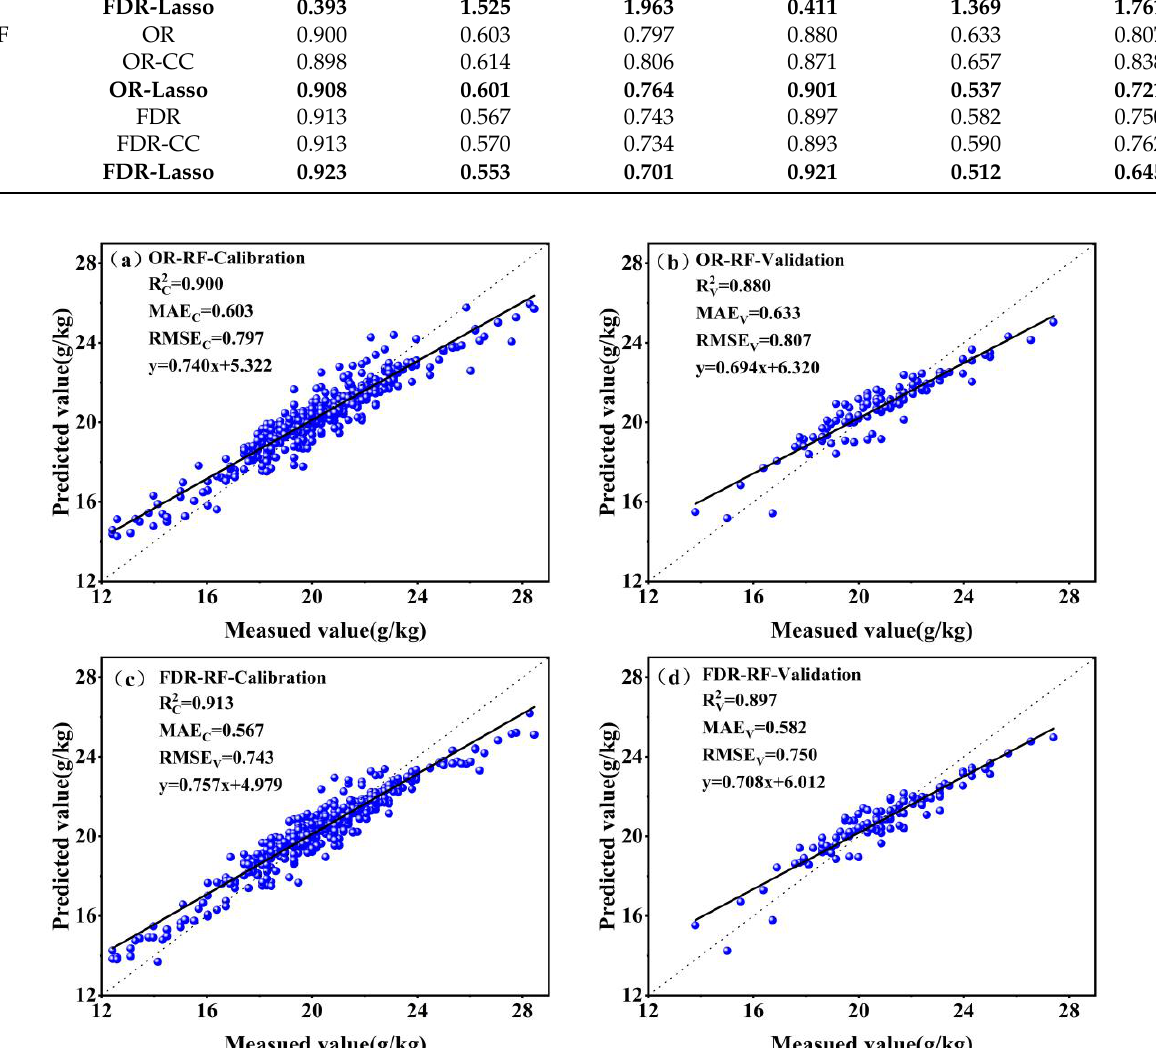
Figure 6. Scatter plot of predicted and measured SOM values for the full-band RF model (( a ) OR-RF-Calibration; ( b ) OR-RF-Validation; ( c ) FDR-RF-Calibration; ( d ) FDR-RF-Validation).